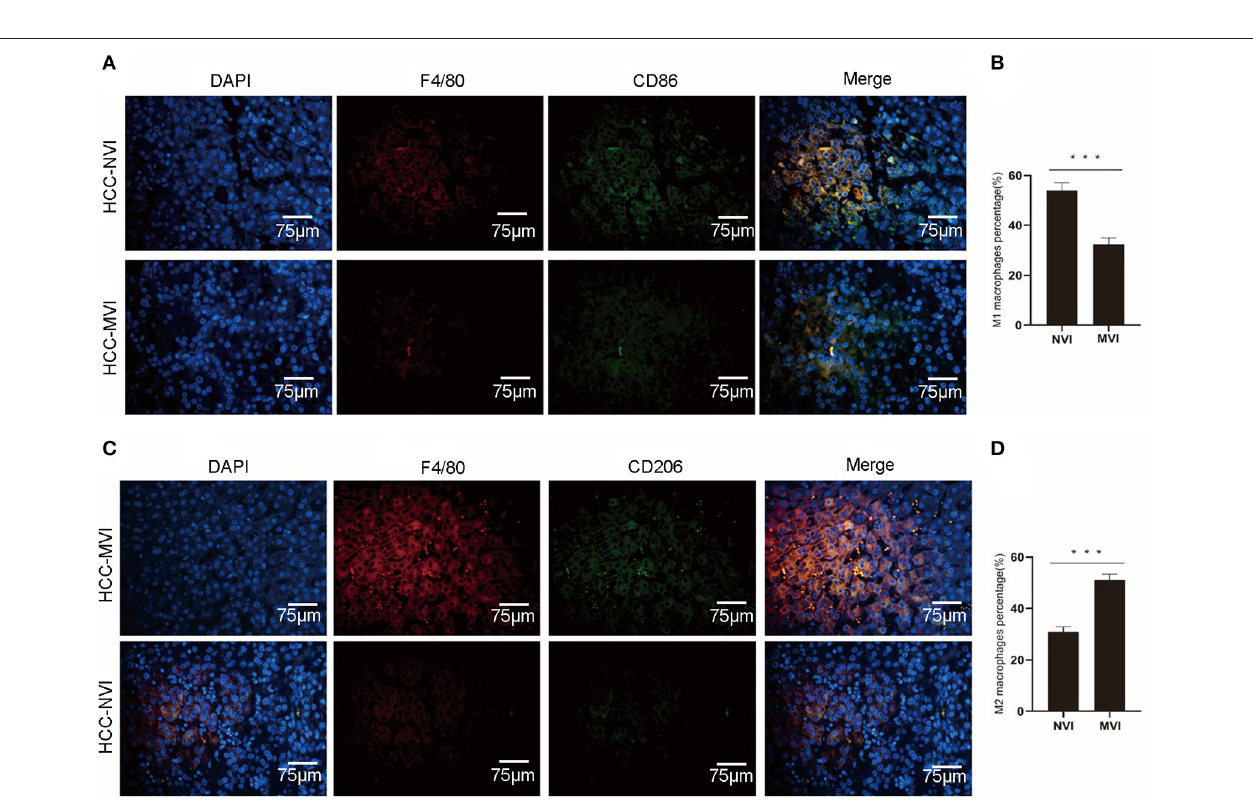
FIGURE 7 | Immunohistochemical profiles of HCC. (A) Representative immunohistochemistry images reveal increased expression of CD8 + T cell in the HCC-MVI and HCC-NVI group (4 × , 20 × and 40 × magnification, respectively). Scale bar: 50 µ m. (B) Percentage of CD8 + T cell in HCC-MVI and HCC-NVI groups, ** P < 0.01 by t-test.